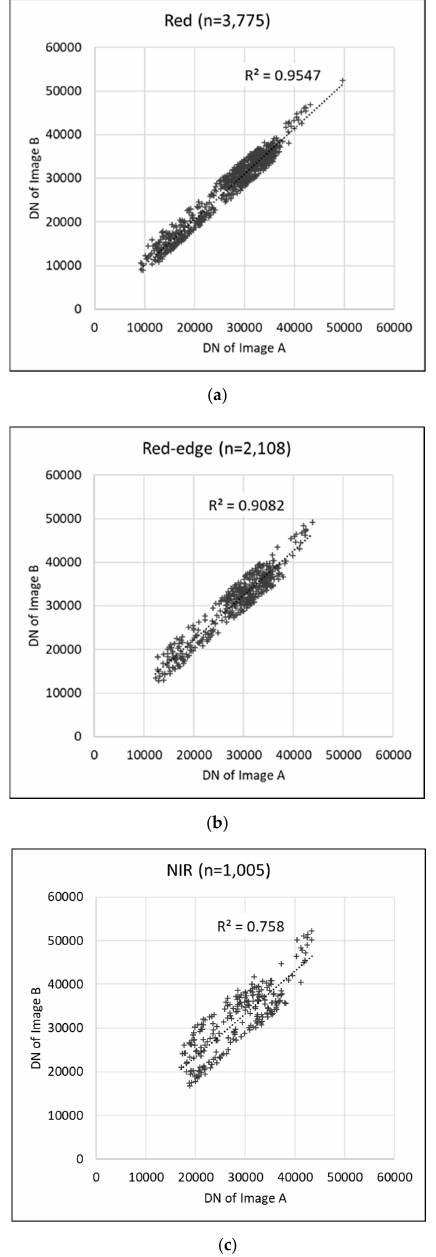
Figure 16. Distribution of DNs for an image pair in ( a ) red, ( b ) red-edge, and ( c ) NIR bands. The second reason might be the error caused by land-cover type. Spectral reflectance is depending on surface materials. In particular, RMSE of red-edge and NIR bands could be highly affected by high reflectance of vegetation. The 200 validation points were grouped according to land-cover types and RMSE of each land-cover type was compared. Table 5 shows RMSEs of validation points for land-cover types. The RMSE of each class in each band was similar among the three relative radiometric calibration methods. This implies that the reason of higher RMSEs of red-edge and NIR bands is not likely due to spectral characteristics but due to the insufficient number of tie points in those bands. Despite the exceptions for red-edge and NIR bands, qualitative analysis showed that the use of tie points and an optimal path can improve the quality of relative radiometric calibration. Table 5. RMSE of the three calibration methods for land-cover types. Band